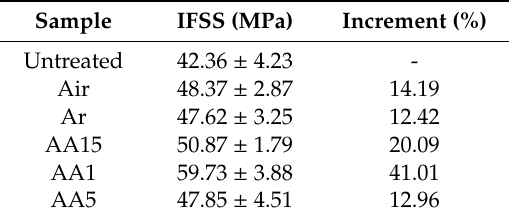
Figure 11. SEM images of samples after microdroplet test. ( a ) The beginning of CF / PEEK, ( b ) the ending of CF / PEEK, ( c ) the beginning of CF / PEEK–Air, ( d ) the ending of CF / PEEK–Air, ( e ) the beginning of CF / PEEK–Ar, ( f ) the ending of CF / PEEK–Ar, ( g ) the beginning of CF / PEEK–AA15, ( h ) the ending of CF / PEEK–AA15, ( i ) the beginning of CF / PEEK–AA1, ( j ) the ending of CF / PEEK–AA1, ( k ) the beginning of CF / PEEK–AA5, ( l ) the ending of CF / PEEK–AA5. Table 6. IFSS of untreated and plasma treated CF / PEEK system.